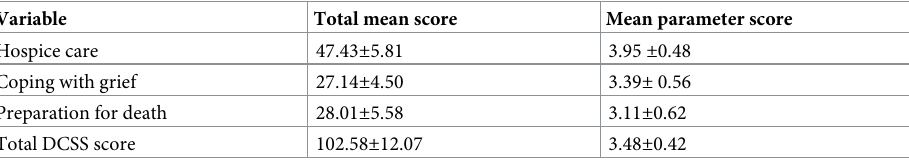
Table 2. Mean death-coping self-efficacy scale scores of the nurses (N =